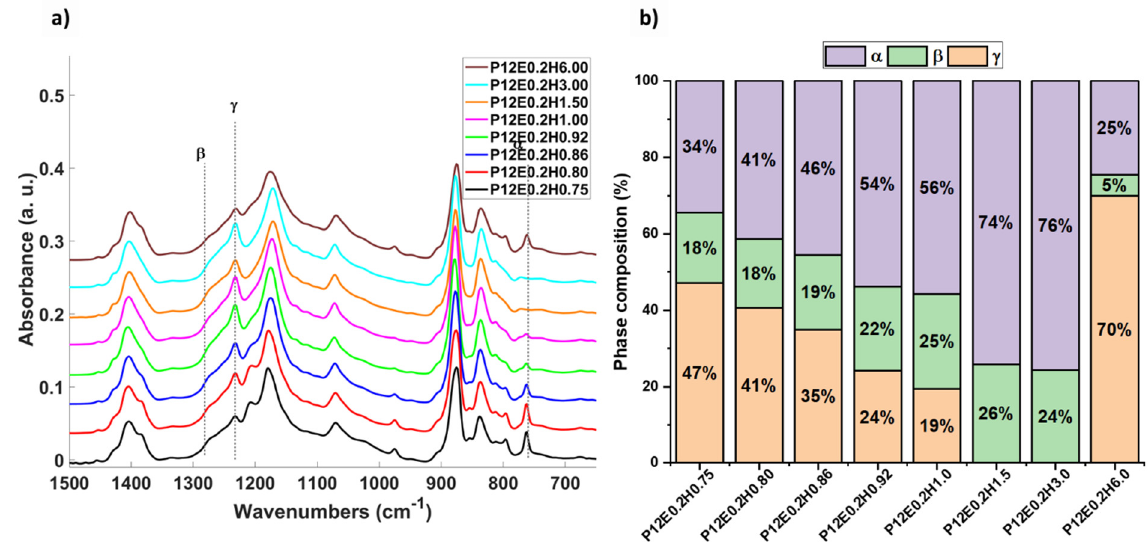
Figure 5. ( a ) FTIR spectra of the aerogels at fixed PVDF concentration of 12 wt.% with varied PVDF/H 2 O ratio from 0.75 to 6; ( b ) crystalline phase composition of the PVDF aerogels. In comparison, water has a slightly larger dipole moment (1.85 D) than ethanol (1.66